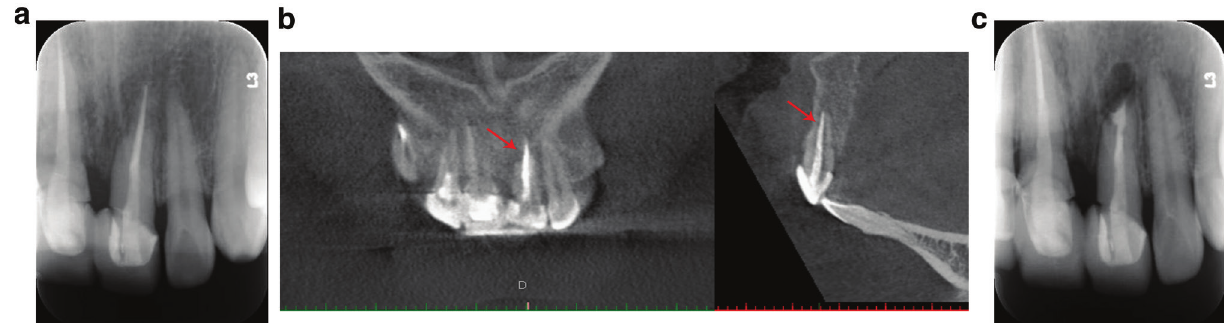
Fig. 1. Diagnostic radiograph showing the RRR lesion of tooth 21 (a), CBCT scan showing an RRR lesion image (b), and post- operative radiograph indicating that the lesion was removed and the root-end cavity was adequately filled